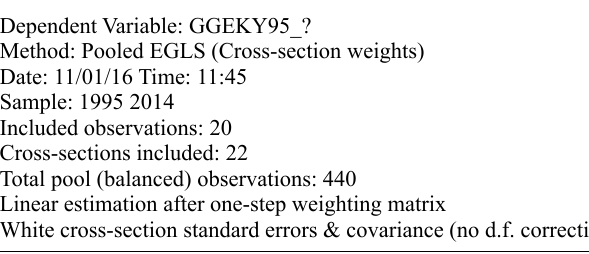
Table 4. Regression parameter estim for the extended model of whole